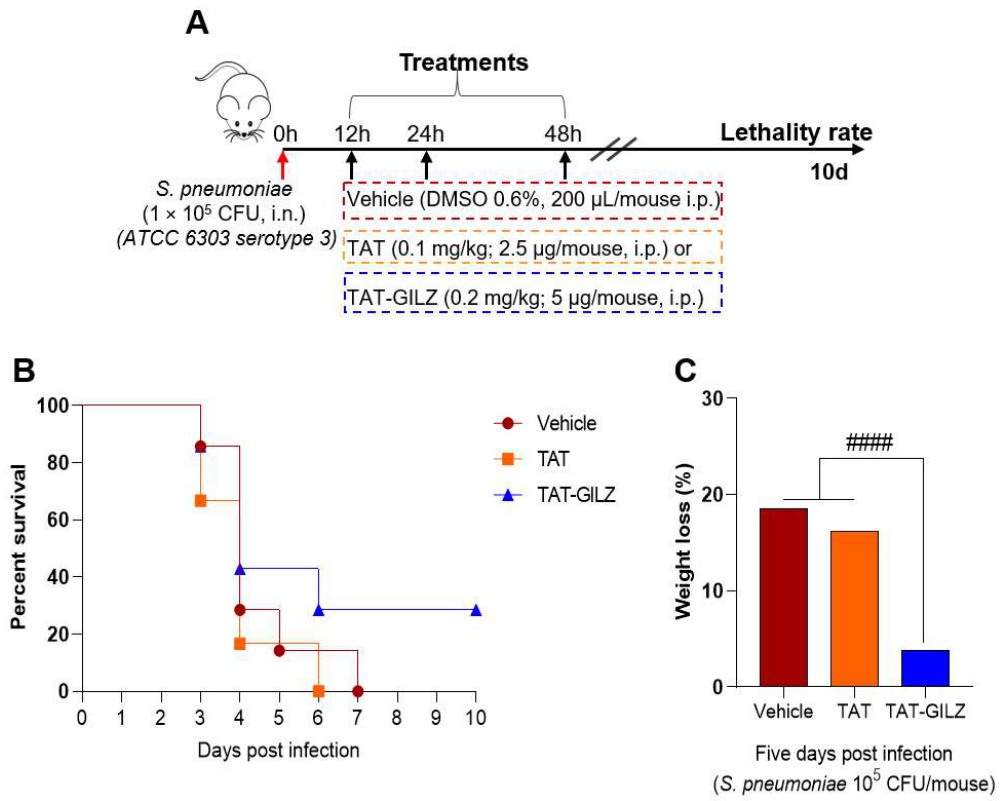
Figure 7. TAT-GILZ treatment rescued 30% of mice from lethal pneumonia. BALB/c mice were infected with S. pneumoniae (1 × 10 5 CFU, i.n.), treated with TAT (0.1 mg/kg, i.p.) or TAT-GILZ (0.2 mg/kg, i.p.) at 12, 24 and 48 h p.i. ( A ), the groups were monitored for lethality rates ( B ) percentage of weight lost at day five ( C ). Vehicle group received DMSO 0.6%. N = 6–7 animals per group. #### p < 0.0001 when comparing TAT-GILZ-treated pneumococcal pneumonia mice to vehicle or TAT groups, by 1-way